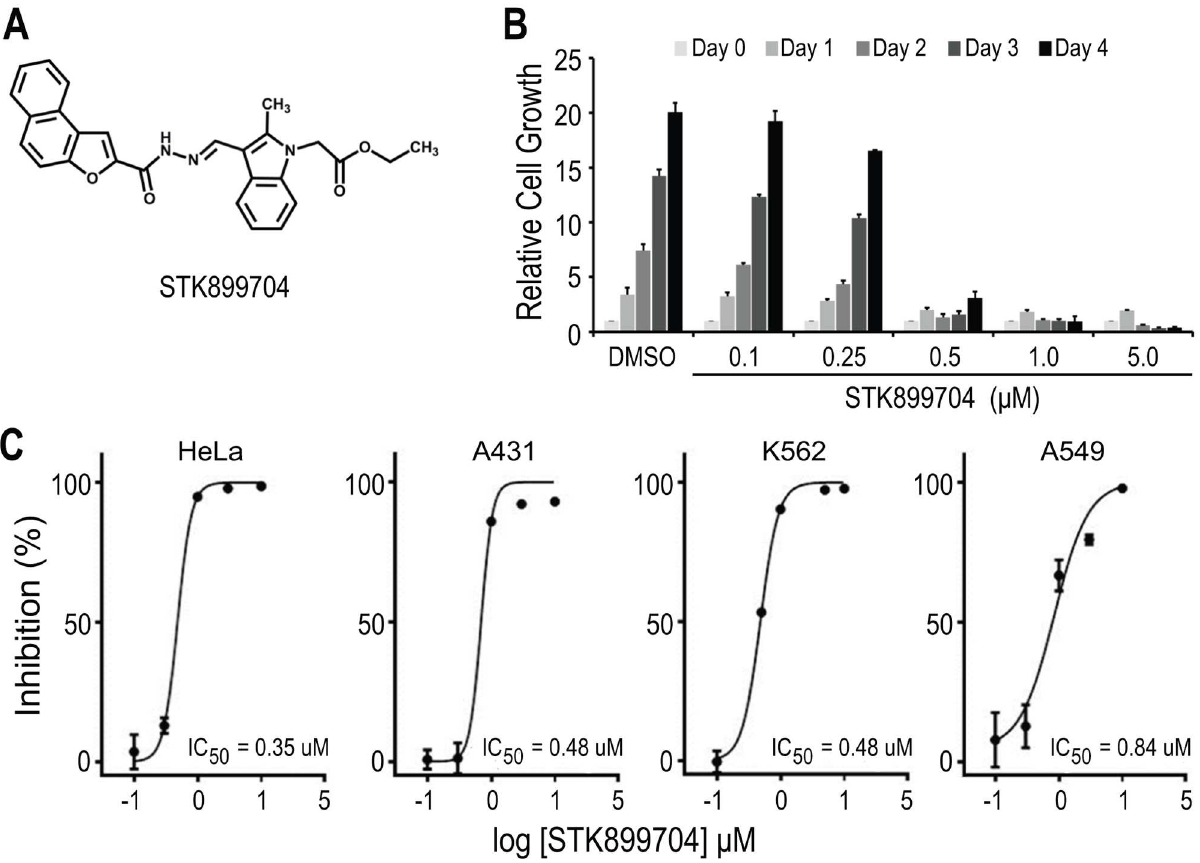
Fig 1. STK899704 suppressed the growth of a varietyof human cancer cell lines. (A) Chemical structure of STK899704.(B) Antiproliferative effect of STK899704on HeLa cells. Cells were seededat 2 x 10 3 cells in 96-wellplate and treated with various concentrations of STK899704 for 4 days. Cell growth was determinedby MTT assay. (C) Inhibitoryeffects of STK899704on the growth of various cancer cell lines. Data were fitted with dose-response curve by using GraphpadPrism software.